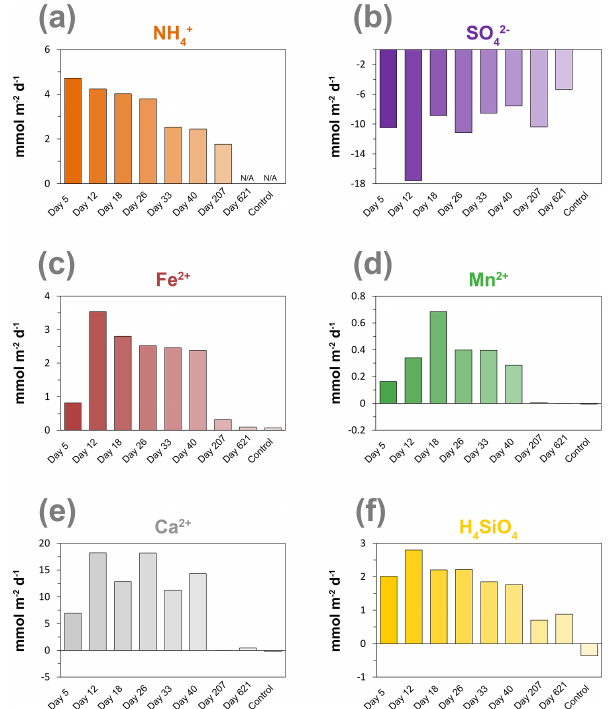
Figure 6. Time series of diffusive fluxes calculated from the linear gradient of the pore water profiles of (a) NH + (d) Mn 2 + , (e) Ca 2 + and (f) H 4 SiO 4 in mmolm − 2 d − 1 towards the oxic zone of the sediment, based on the linear pore water gradients (Sect. 1.6; Figs. S4–S9). Here, a positive value indicates an upward flux, whereas a negative value represents a downward flux. NA – not available. The control core was sampled at day